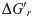
Computed pathways for L-serine biosynthesis: r1, r2, r3 and r4.Rectangles represent reaction edges, and the data in parentheses denote the value ΔG′r of reaction and the compound similarity respectively.